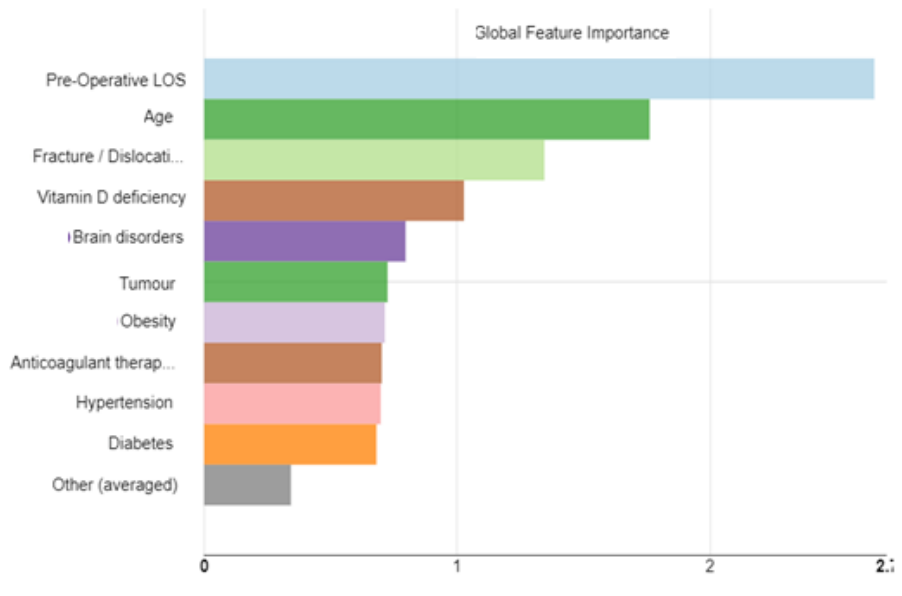
Figure 6. Global importance Feature.